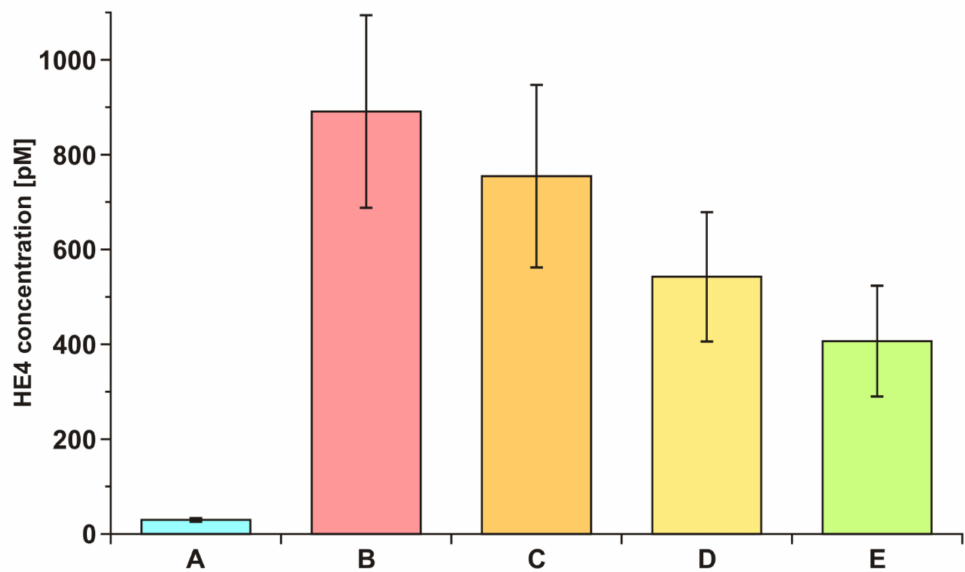
Figure 5. HE4 concentration in blood serum of ovarian cancer patients (n = 7) before (B) and after 6 h (C), 24 h (D), and 5 days (E) after tumor resection. (A) healthy volunteers (n =